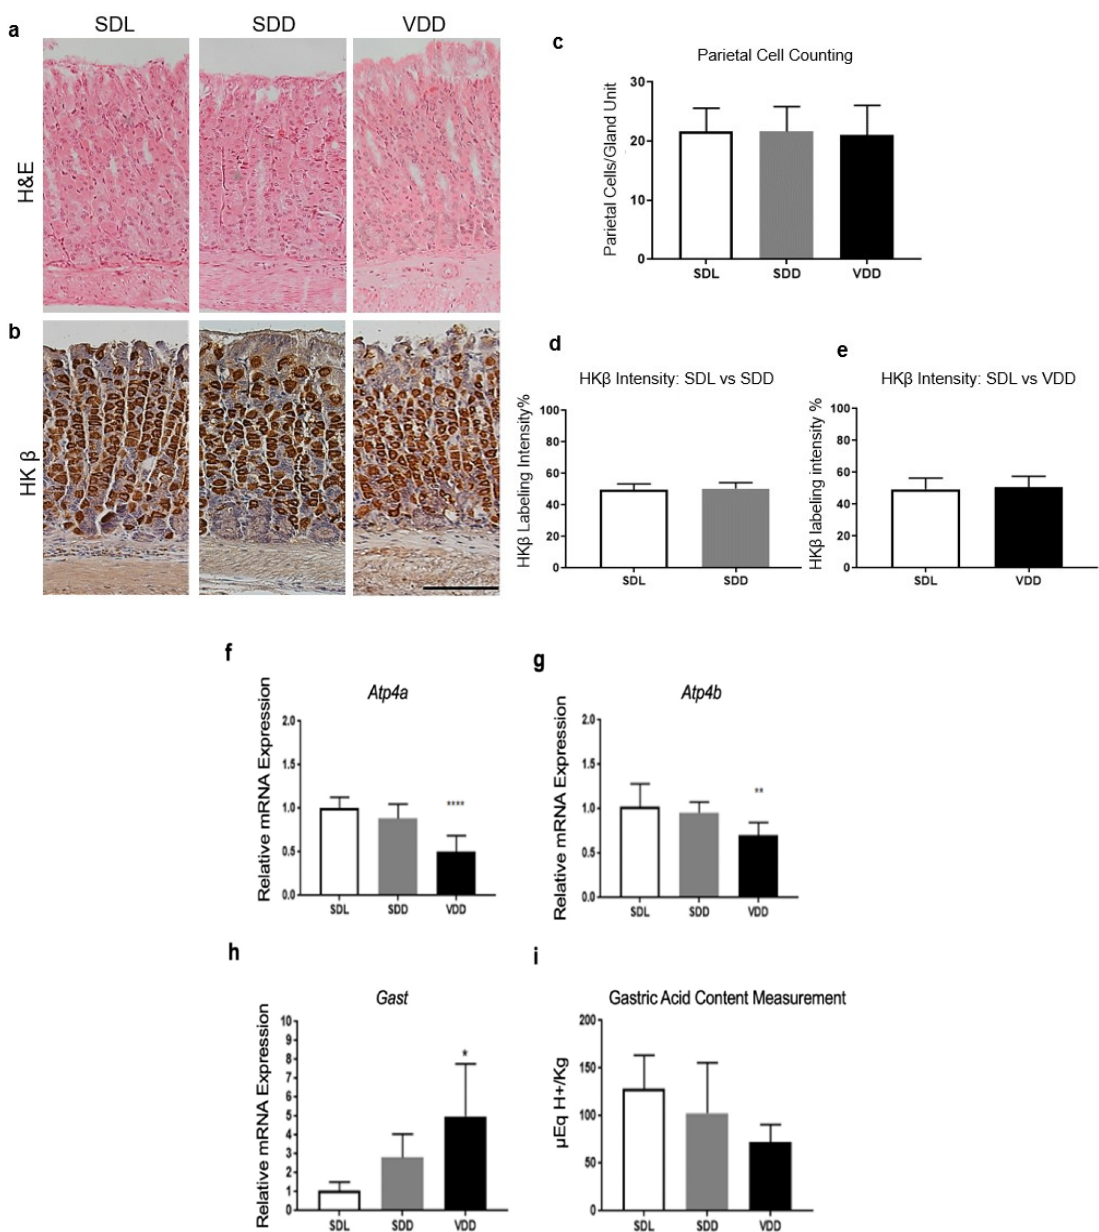
Figure 4. Effect of a VD-deficient diet on weight and VD serum levels. Diets containing 25 IU/kg-VD3 (VD3, deficient diet) or 1000 IU/kg (standard diet) were administered to approximately 4-month-old mice (n = 7/group) to assess their effects on serum 25(OH)D and weight. ( a ) VDD mice gained more weight than the controls. ( b ) VDD mice exhibited a significant reduction in 25(OH)D serum concentration presented as the mean (ng/mL) ± SD. A one-way ANOVA was used for the serum 25(OH)D analysis and a two-way ANOVA was performed for the weight analysis. ** p < 0.01, **** p < 0.0001.